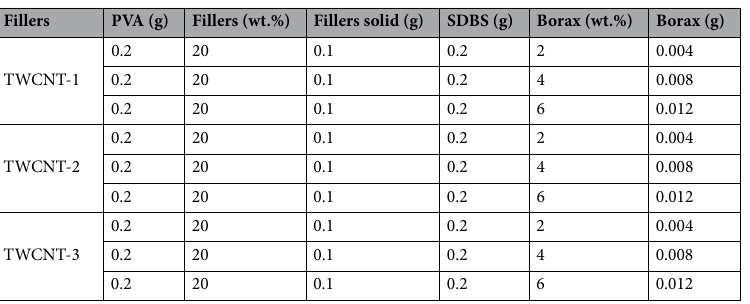
Table 2. Concentrations of TWCNT, PVA, SDBS, and borax in nanocomposites.